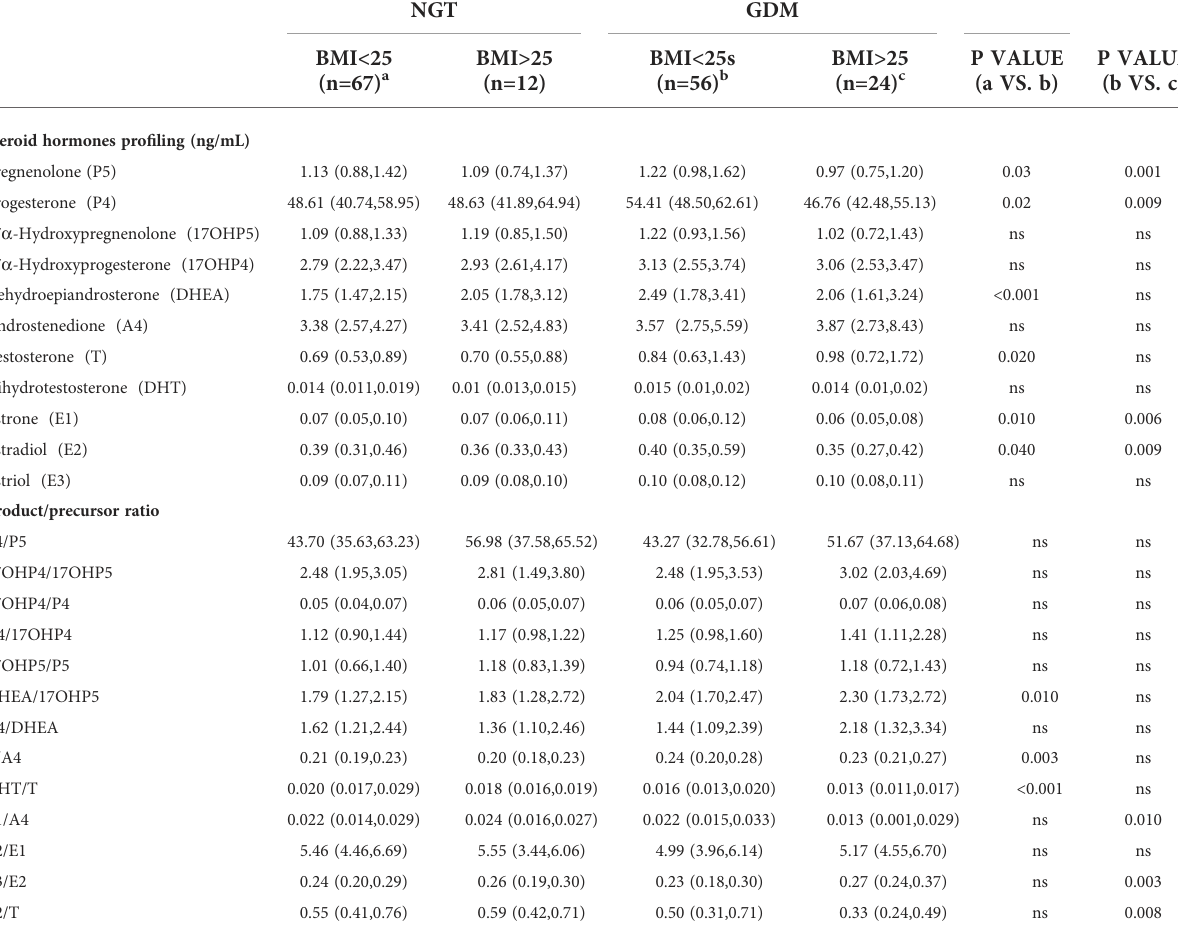
TABLE 5 Steroid hormones pro fi ling and product/precursor ratios of GDM group and NGT group with different maternal